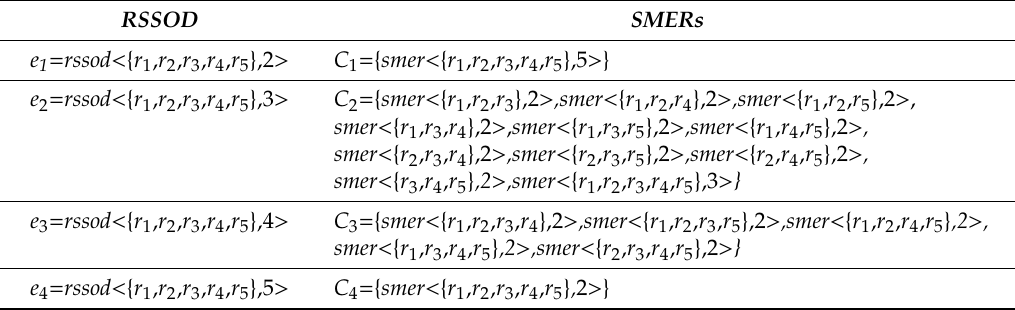
Table 2. Static and soft mutually exclusive roles (t - m SMERs) enforce k - n role-static separation-of-duty constraint (RSSOD). RSSOD